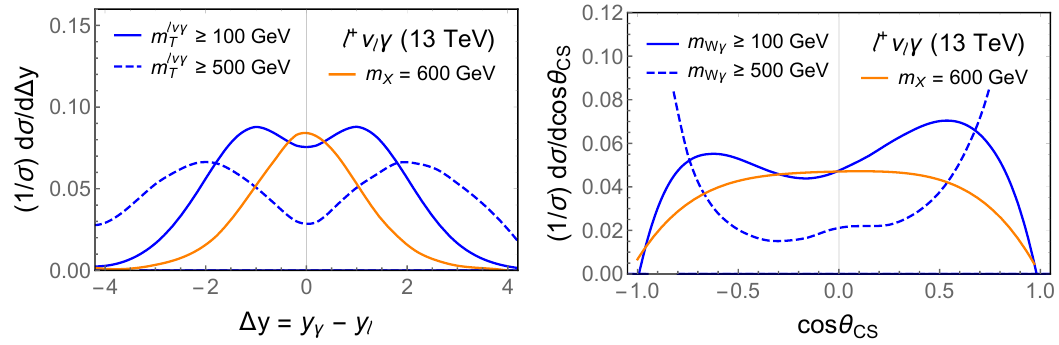
Figure 3 . Proton level distributions of W + ( ‘ + (cid:23) ) (cid:13) production. The panels show the background and signal shape of two distributions: the di(cid:11)erence of the photon and lepton rapidities (cid:1) y (left), and the Collins-Soper angle cos (cid:18) CS (right). Solid lines show the distributions including the cuts in eqs. (2.2), (2.3), (2.4) only, while the dashed lines show the distributions after an extra cut